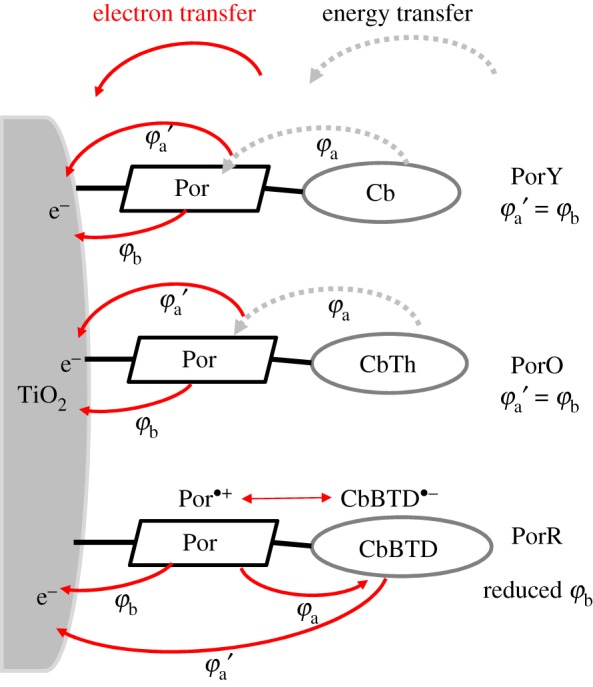
Electron/energy transfer pathways of the investigated dyes on TiO2 thin films.